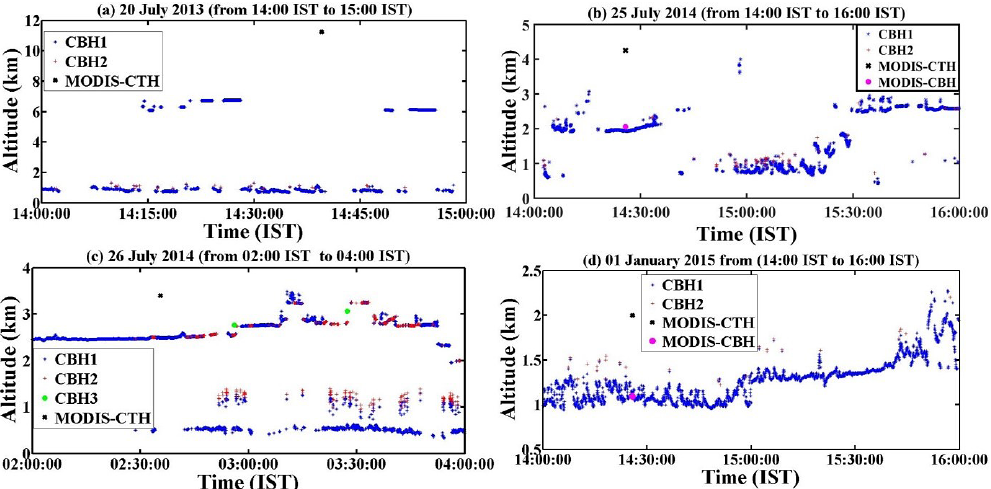
Figure 5. Comparison between cloud top height and CBH derived from MODIS, and base height measured by Ceilometer CL31 over the Ahmedabad region.